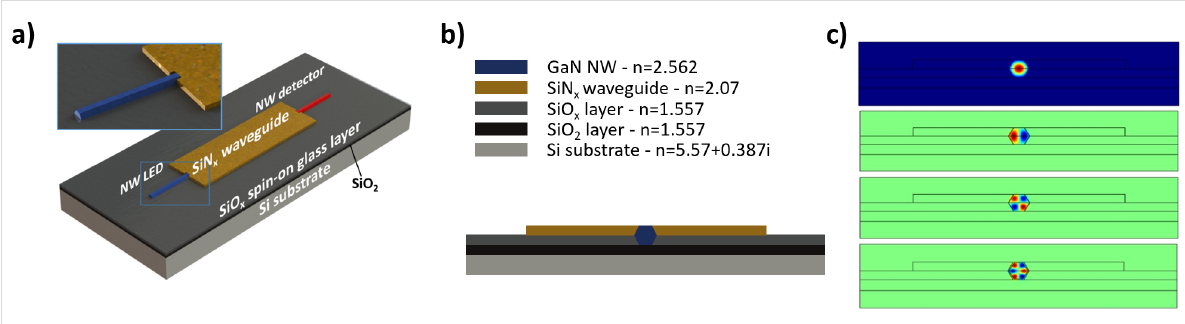
Figure 1: (a) Schematic illustration of the platform geometry used for the FDTD simulations. The platform consists of a NW LED, waveguide and NW photodetector; (b) Front-view cross-section schematic illustration with refractive indices for materials used in the simulations given; (c) The funda- mental mode and three higher order modes of a hexagonal GaN NW with a diameter of 1 µm for the wavelength of 400 nm. The fundamental mode was used for the FDTD